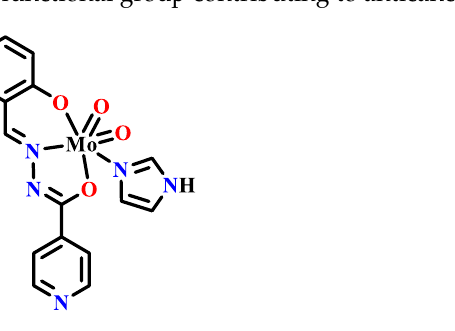
Figure 33. A Mo VI O 2 complexes of naphthylhydrazone with isonicotinamide as the side chain and with imidazole as the co-ligand. with imidazole as the co-ligand.